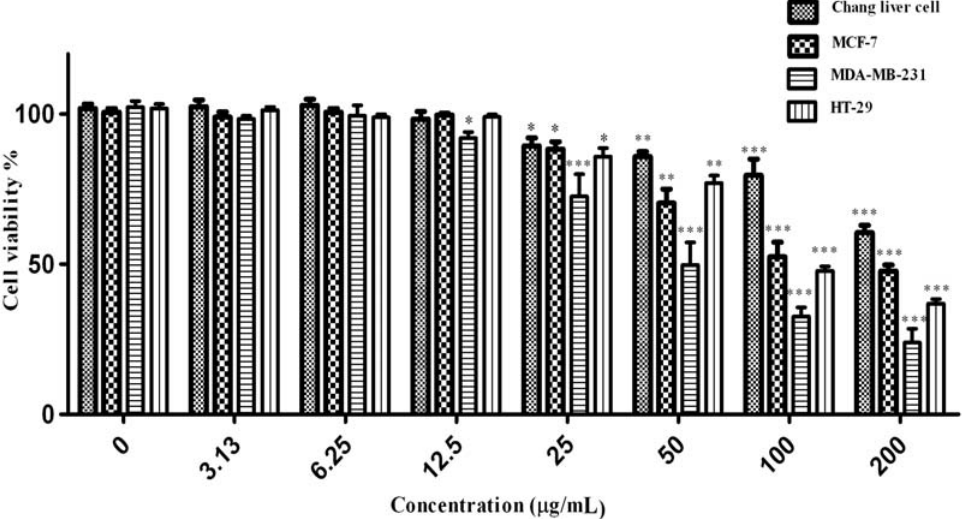
Figure 8. Effect of crude methanolic extract of Citrus blooms on Chang liver, MCF-7, MDA-MB 231 and HT-29 cells survival. All values represent the mean ± S.E.M from three independent experiments. *** p < 0.001, ** p < 0.01 and * p < 0.1 indicate significant difference compared to the untreated control group.